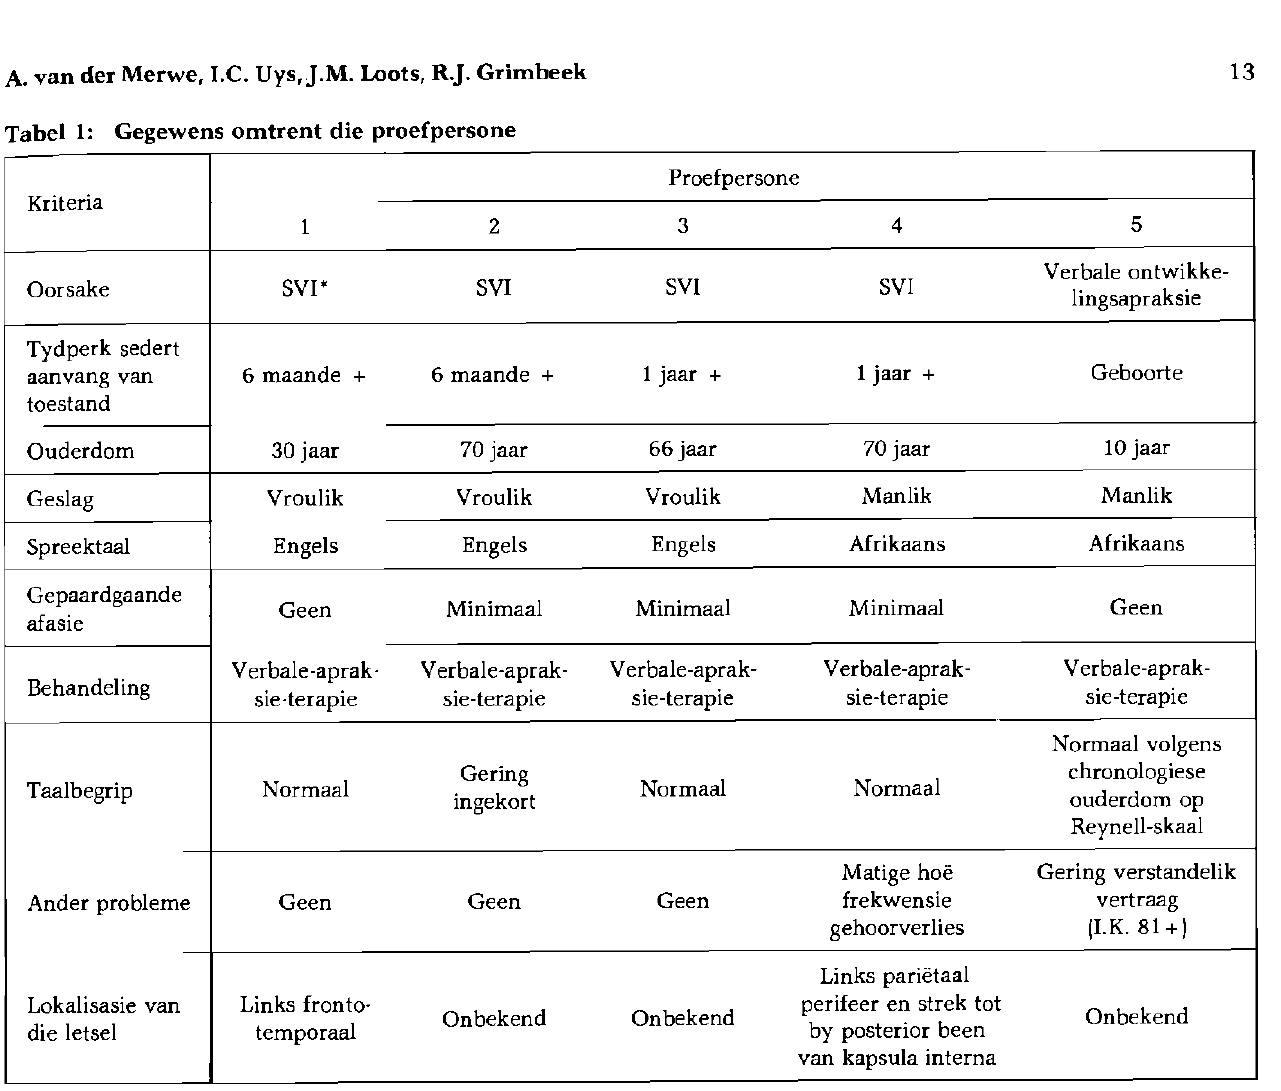
Tabel 1: Gegewens omtrent die proefpersone